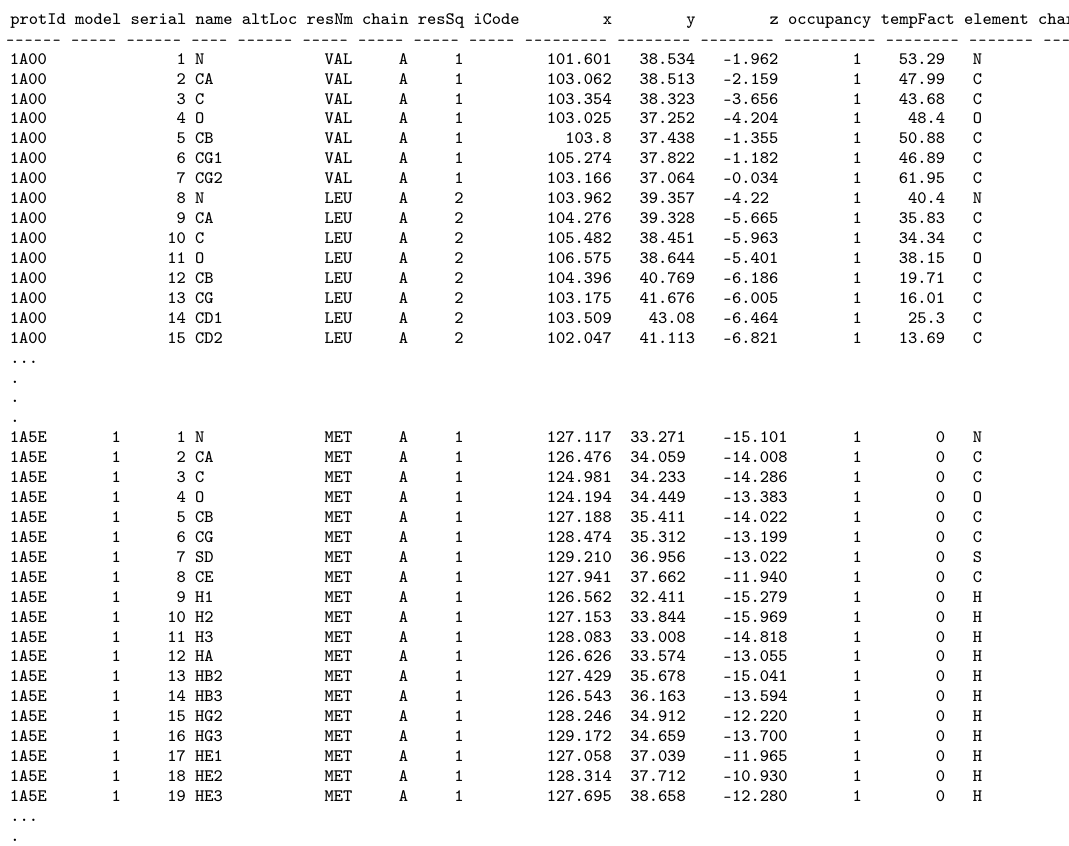
Figure 2. Results of the extraction of the ATOM section performed with the U-SQL script from Listing 1 showing a part of produced